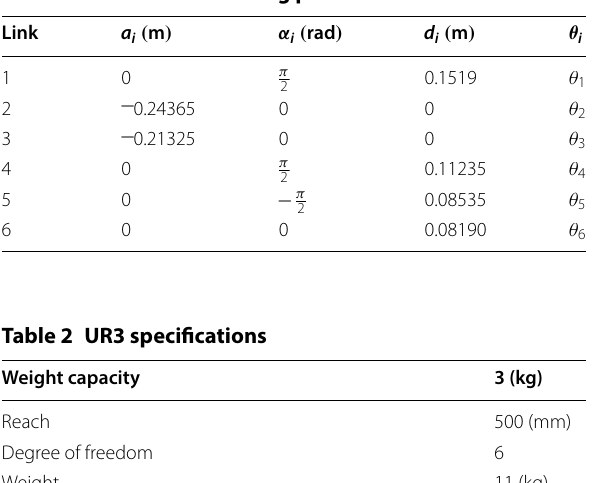
Table 1 Denavit–Hartenberg parameters for UR3